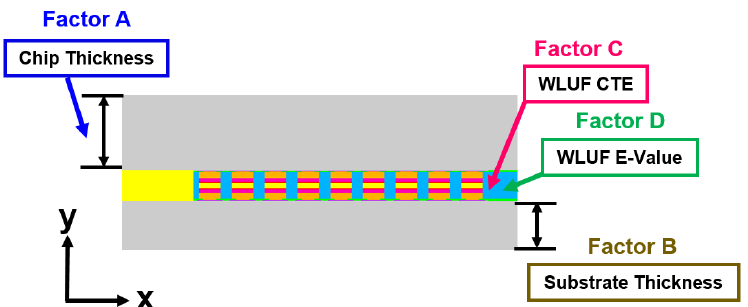
Figure 10. Schematic of locations for four considered factors in the proposed chip stacking